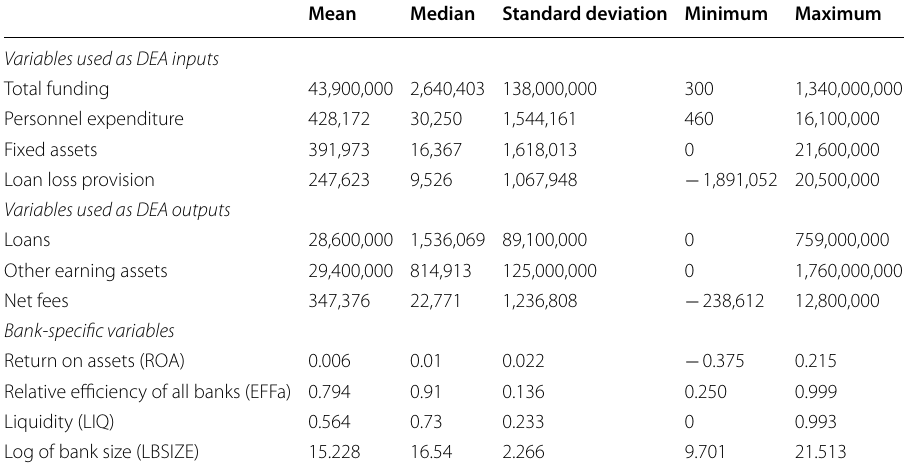
Table 5 Descriptive statistics of input/output